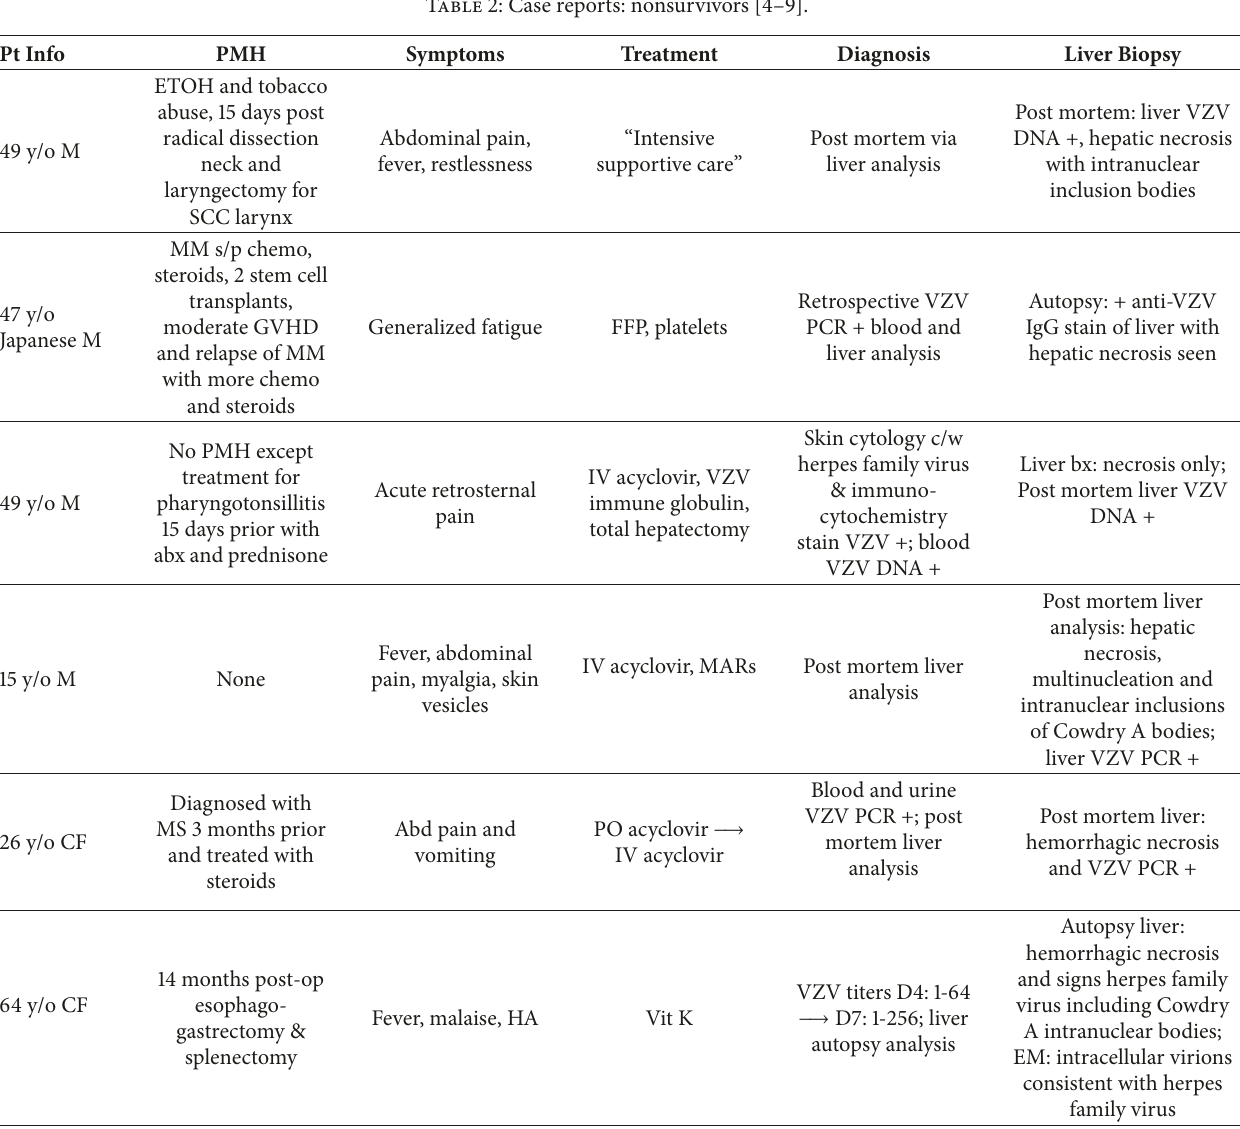
Table 2: Case reports: nonsurvivors